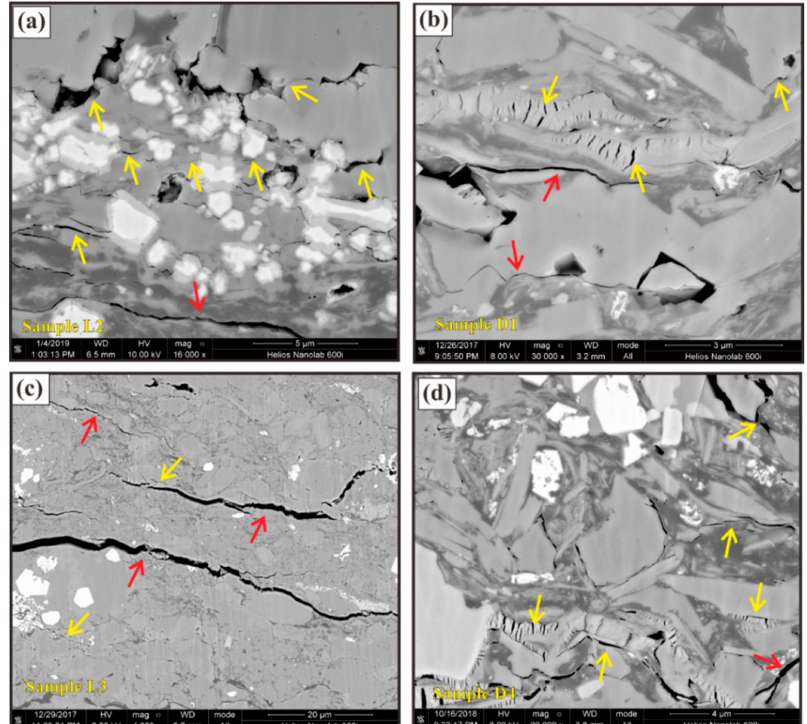
Figure 4. SEM photomicrograph images of fracture-related pores in Lujiaping deformed shales. Natural microchannels are indicated with yellow arrows whereas the microfractures are indicated with red arrows. ( a ) Fracture-related pores within sample L2; ( b ) fracture-related pores within sample D1; ( c ) fracture-related pores within sample L3; ( d ) fracture-related pores within sample